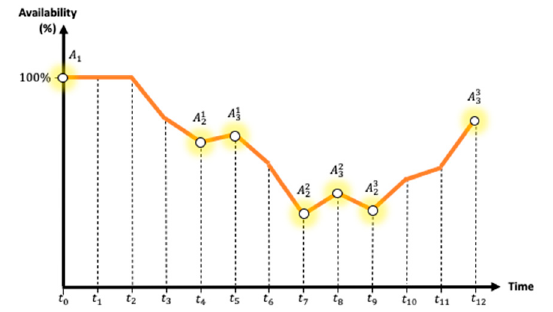
Figure 7. Schematic representation of the availability values considered by the Equation (2).